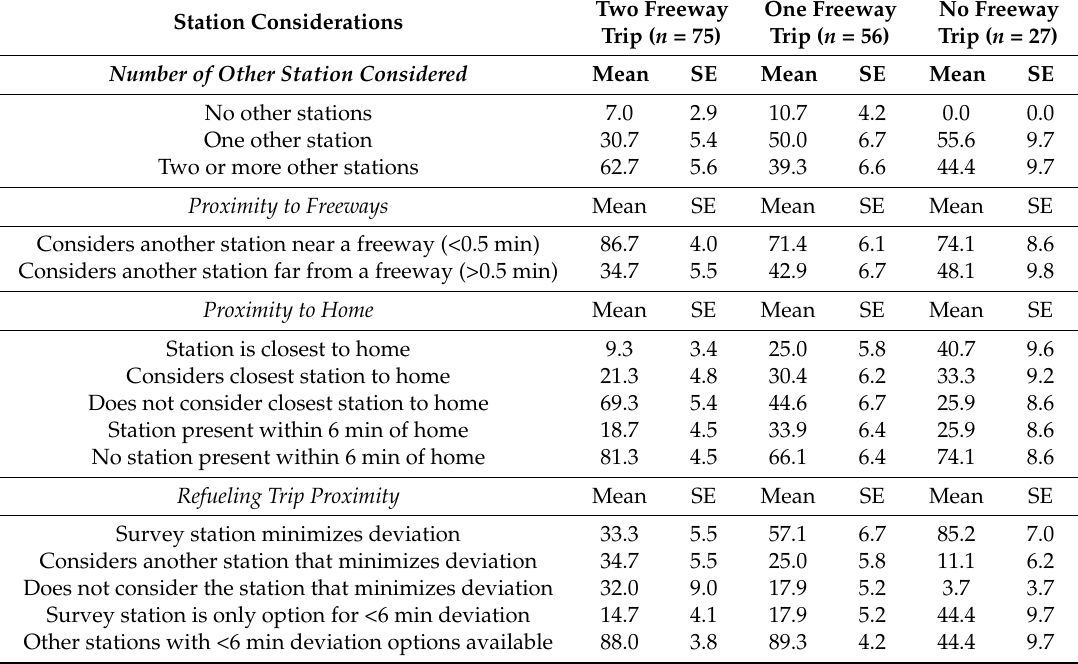
Table 2. Summary statistics of survey site station characteristics and other stations considered by respondents, by freeway refueling trip type